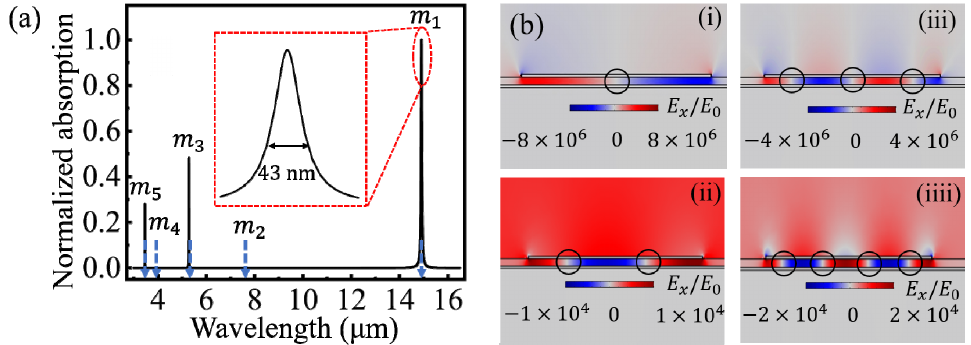
Figure 2. ( a ) Normalized absorption spectrum of the CGS (black line) and the positions of resonance wavelengths solved by using the analytical model (downward dashed blue arrows). The inset in ( a ) shows that the full width at half maximum (FWHM) of the m 1 peak is 43 nm. ( b ) Electric field distributions corresponding to the coupled localized surface plasmon resonances (LSPRs) labeled (i) m 1 , (ii) m 2 , (iii) m 3 , and (iiii) m 4 in ( a ). The chemical potential of graphene is µ c = 0.5 eV. The width of GR is L = 40 nm. The thickness and refractive index (RI) of the dielectric spacer are d = 1.0 nm and n 3 = 1.5,